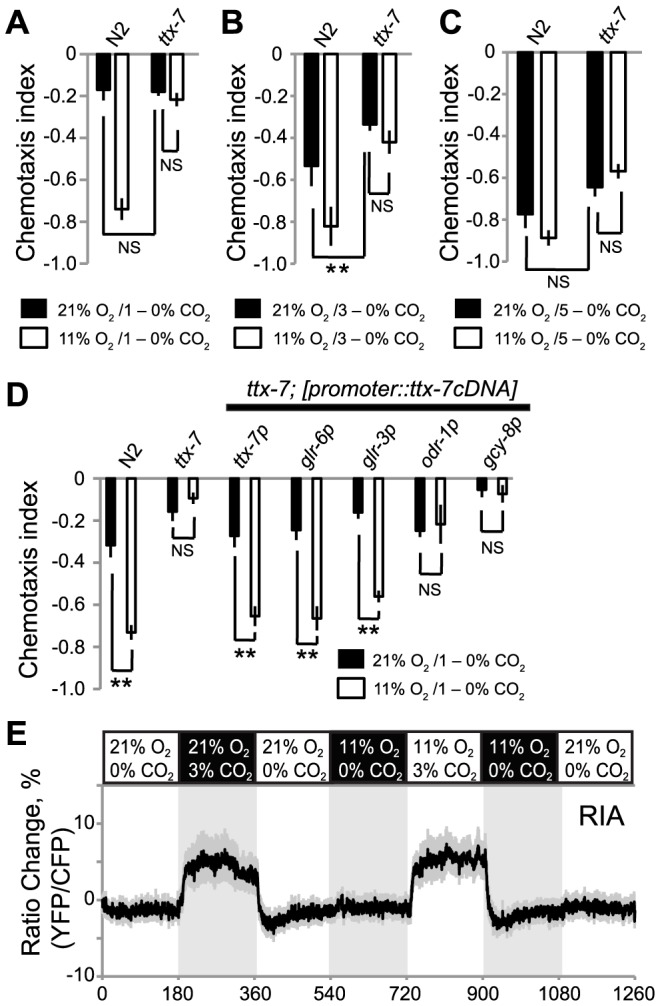
TTX-7 acts in RIA interneurons to promote CO2 avoidance when ambient O2 levels are low.A–C. Mutations in ttx-7 strongly reduce CO2 avoidance at 11% O2 but have relatively weak effects on CO2 avoidance at 21% O2. ns, not significant, ** p<0.01, Student's t test. D. Expressing ttx-7 specifically in RIA neurons, using the glr-3 or glr-6 promoters, restores strong CO2 avoidance to ttx-7 mutants assayed at 11% O2. Expressing ttx-7 specifically in AFD, using the gcy-8 promoter, or in AWB and AWC, using the odr-1 promoter does not rescue the ttx-7 phenotype. ns, not significant, ** p<0.01, Student's t test. E. CO2 evokes a Ca2+ response in RIA neurons. Ca2+ responses were measured in immobilized animals cultivated at 22°C using a pglr-6::YC3.60 Ca2+ reporter. Shading highlights gas switch times. The CO2/O2 stimulus train used is indicated above the plot.